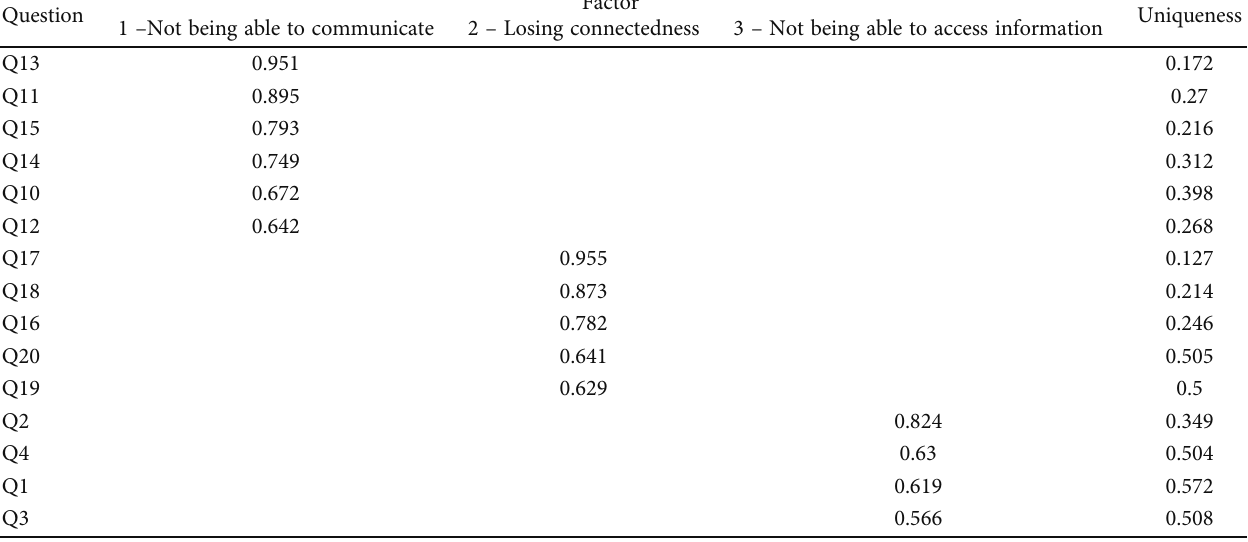
Table 8: Factor loads and uniqueness of each question in model 3.